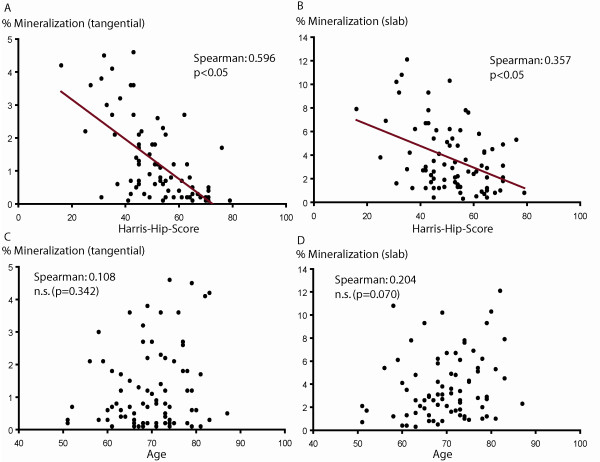
Cartilage mineralization and clinical relationships. Contact radiography (DCR) of tangential cut cartilage and slab specimens revealed mineralization in all articular cartilage specimens. The mean area of mineralization was 1.25% (± 0.14 SE, range 0.1-4.6%) for the tangential cut cartilage and 3.69% (± 0.31 SE, range 0.3-12.1) for the slab specimens. Scatter plots show a highly significant inverse correlation between HHS score and mean cartilage calcification for both the tangential cut articular cartilage and the slab specimens (A and B) (p < 0.01, p = 0.01). There was no correlation between patient age and the mean area of cartilage mineralization (C and D) (p = 0.342, p = 0.070).